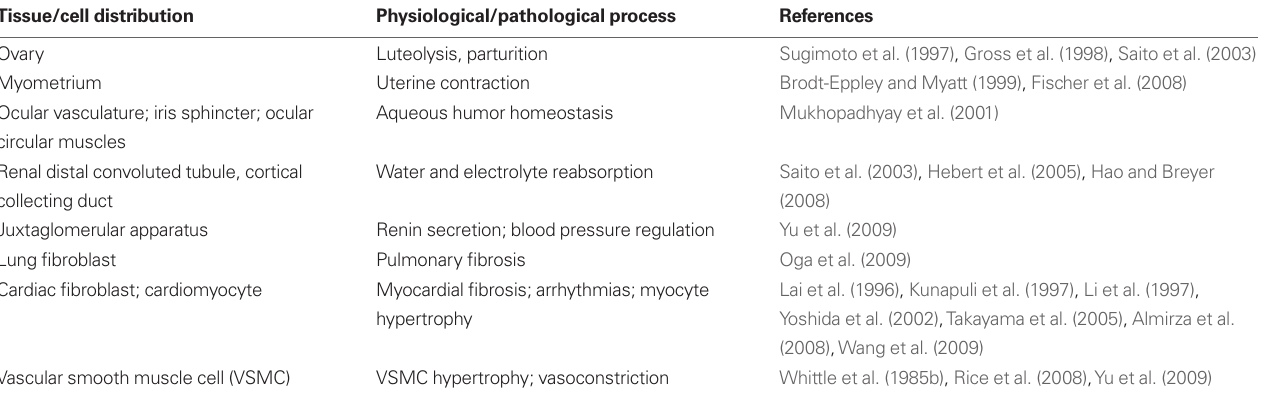
Table 1 | FP expression and its physiological/pathological